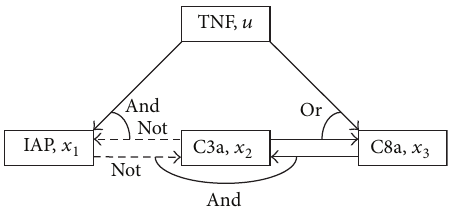
Figure 1: Simplified model of an apoptosis network. Activation (solid), inhibition